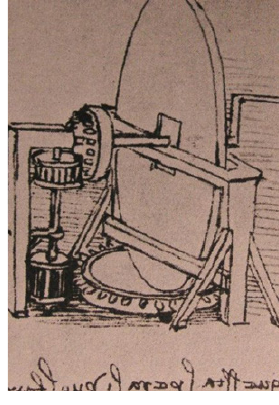
Figure 2. Leonardo’s Lens Grinder [19].